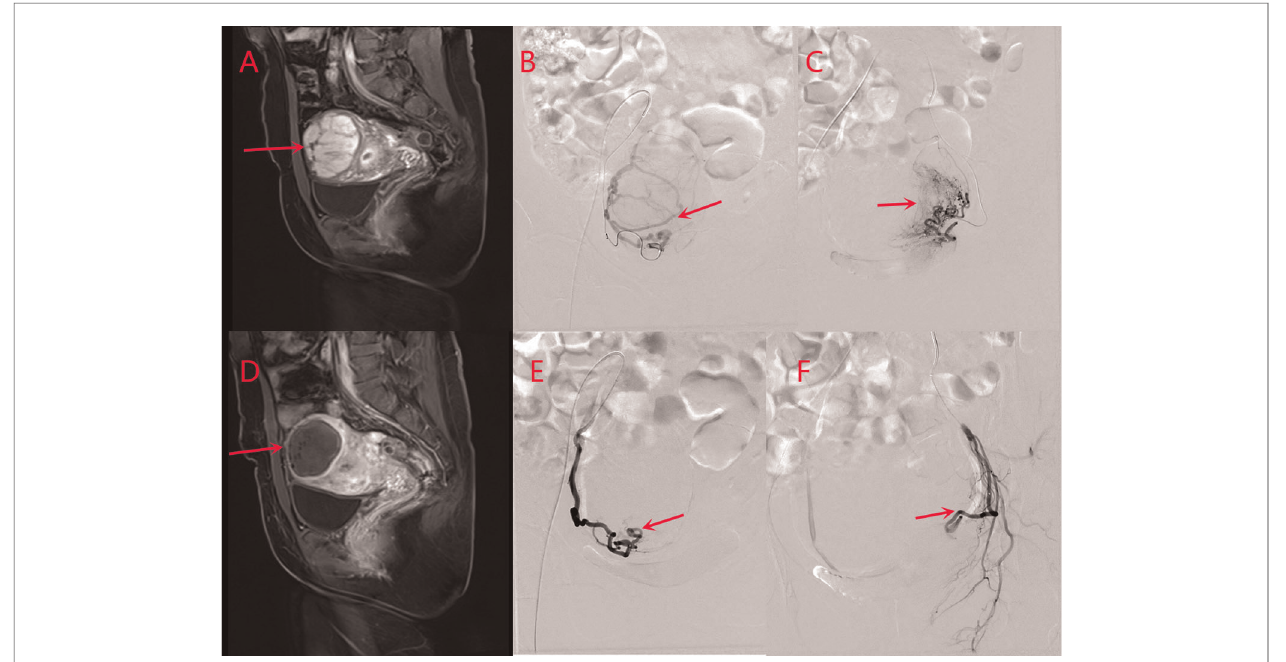
FIGURE 1 | Images from a patient in the study group. ( A ) Before uterine artery embolization, and ( D ) after uterine artery embolization. The volume of uterine leiomyoma is reduced from 7.2 cm×7.4 cm×9.6 cm to 5.4 cm×5.7 cm×7.5 cm as revealed by pelvic MRI contrast, and the enhancement has disappeared. ( B ) Right uterine arteriography and ( C ) left uterine arteriography before uterine artery embolization. ( E ) Right uterine arteriography and ( F ) left uterine arteriography after uterine artery embolization. The bilateral leiomyoma arteries are basically occluded, and blood perfusion has disappeared completely after uterine artery embolization, suggesting the complete infarction of the myoma after uterine artery